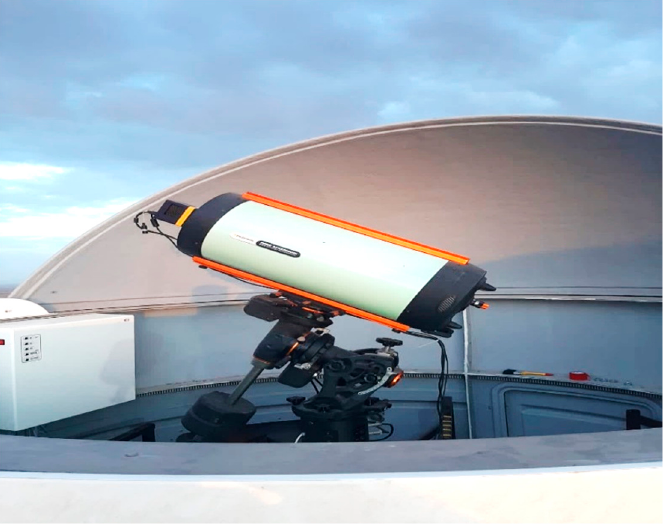
Figure 1. Examples of GEO and GNSS (inside red circle) satellites during observation from the OSTS station.